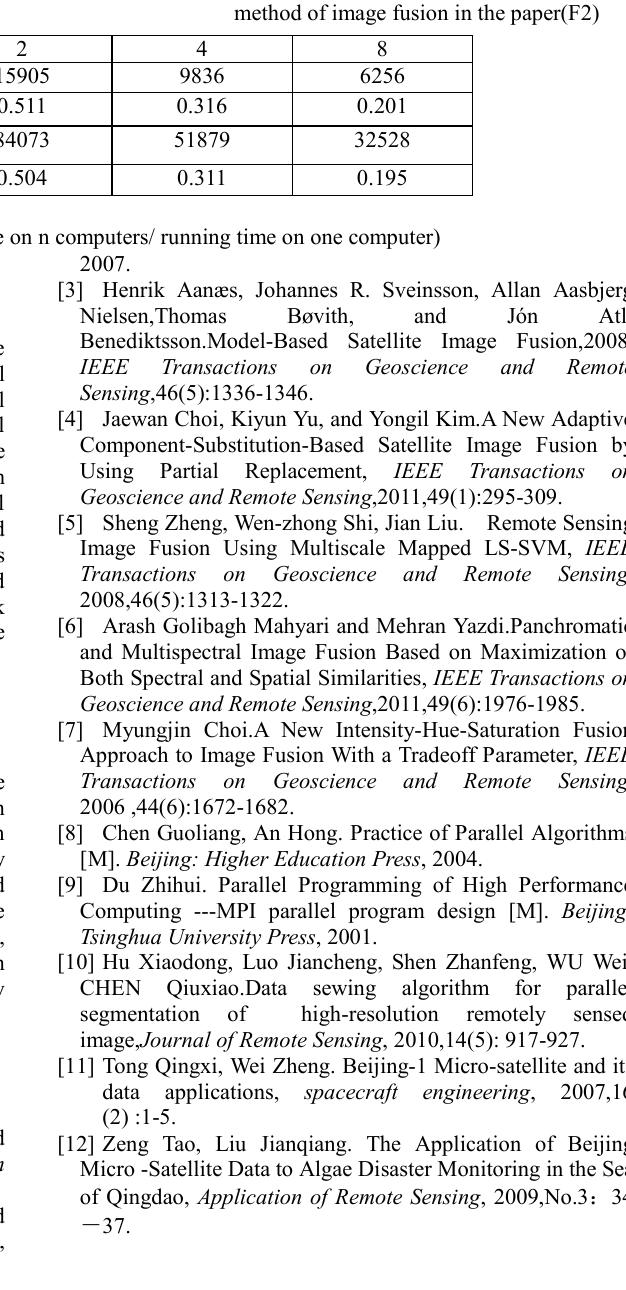
Figure 5. The panchromatic image of Beijing-1 small satellite(P2)